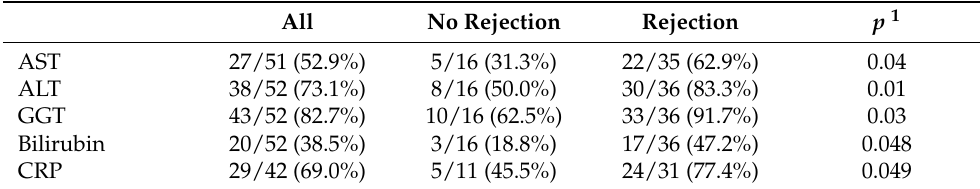
Table 3. Frequency of values > 1.5 times upper limit of normal.